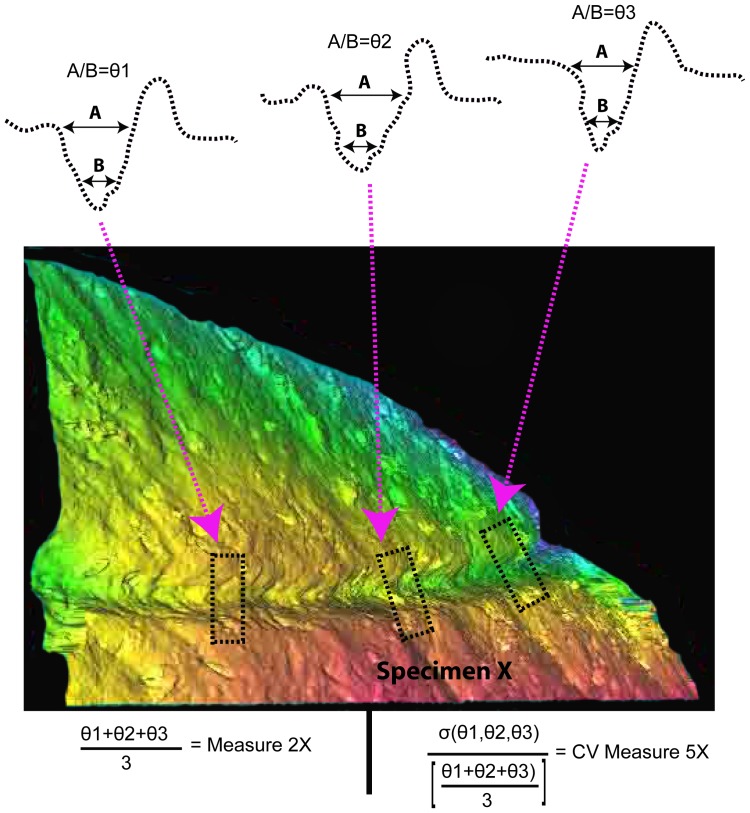
Demonstration of how measurements 5–7 were calculated.